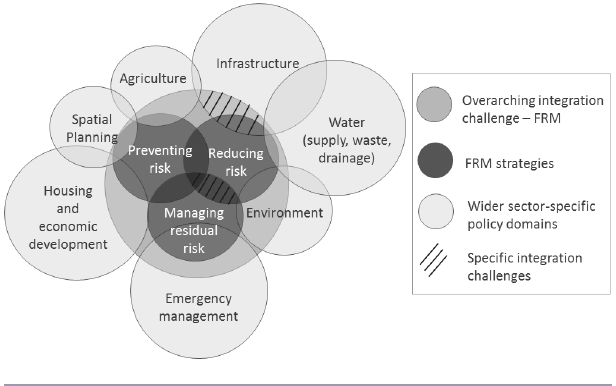
Fig. 2 . Visualization of possible areas for integration between flood risk management (FRM) and other sector-specific policy domains, approximated for